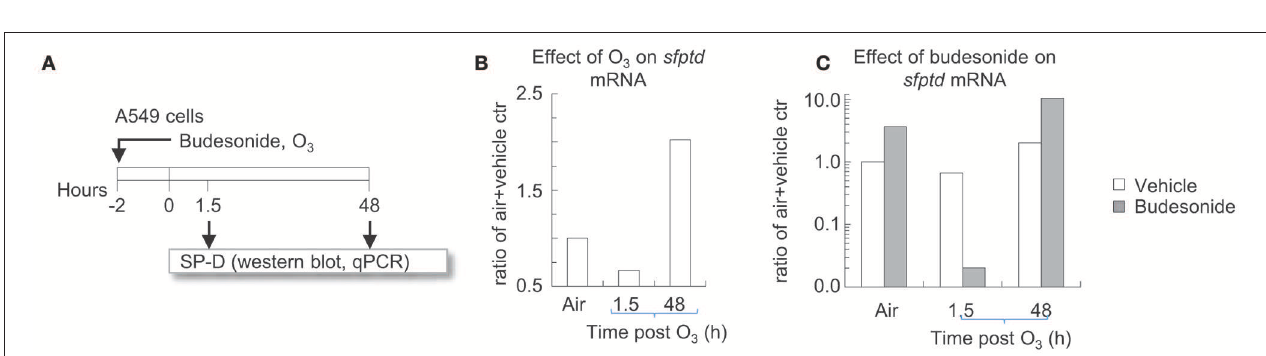
FIGURE 6 | Time dependent effects of O 3 on budesonide-induced sftpd mRNA in A549 cells in vitro. (A) A549 cells were incubated for 2h with budesonide or vehicle (DMSO) and exposed to air or 300 ppb O 3 . 1.5 or 48h after exposure/treatment ended, cells were harvested and processed for RNA extraction. (B,C) sftpd mRNA was measured by qPCR. Fold over air + vehicle values are shown. Representative of three independent